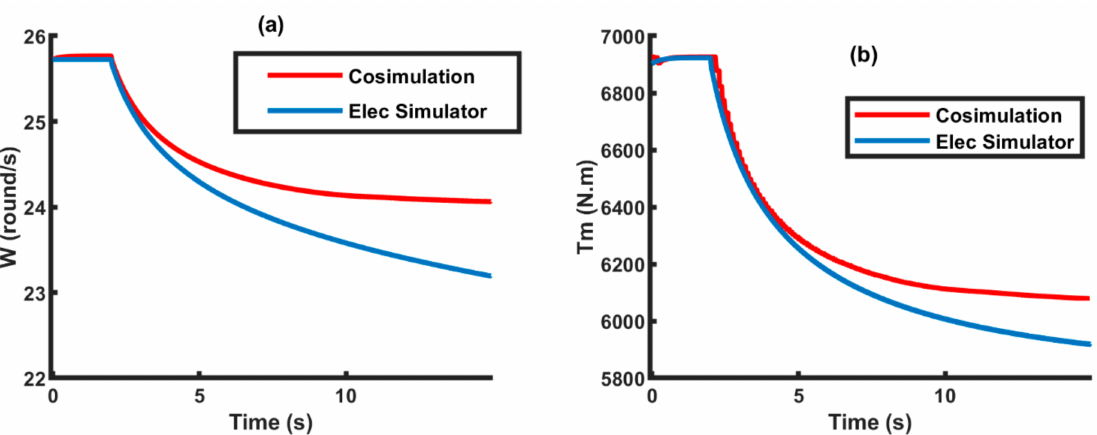
Figure 8. Simulation results of the 1.2 MW asynchronous motor, coupled to a common pump model in Apros; ( a ) speed and ( b ) mechanical